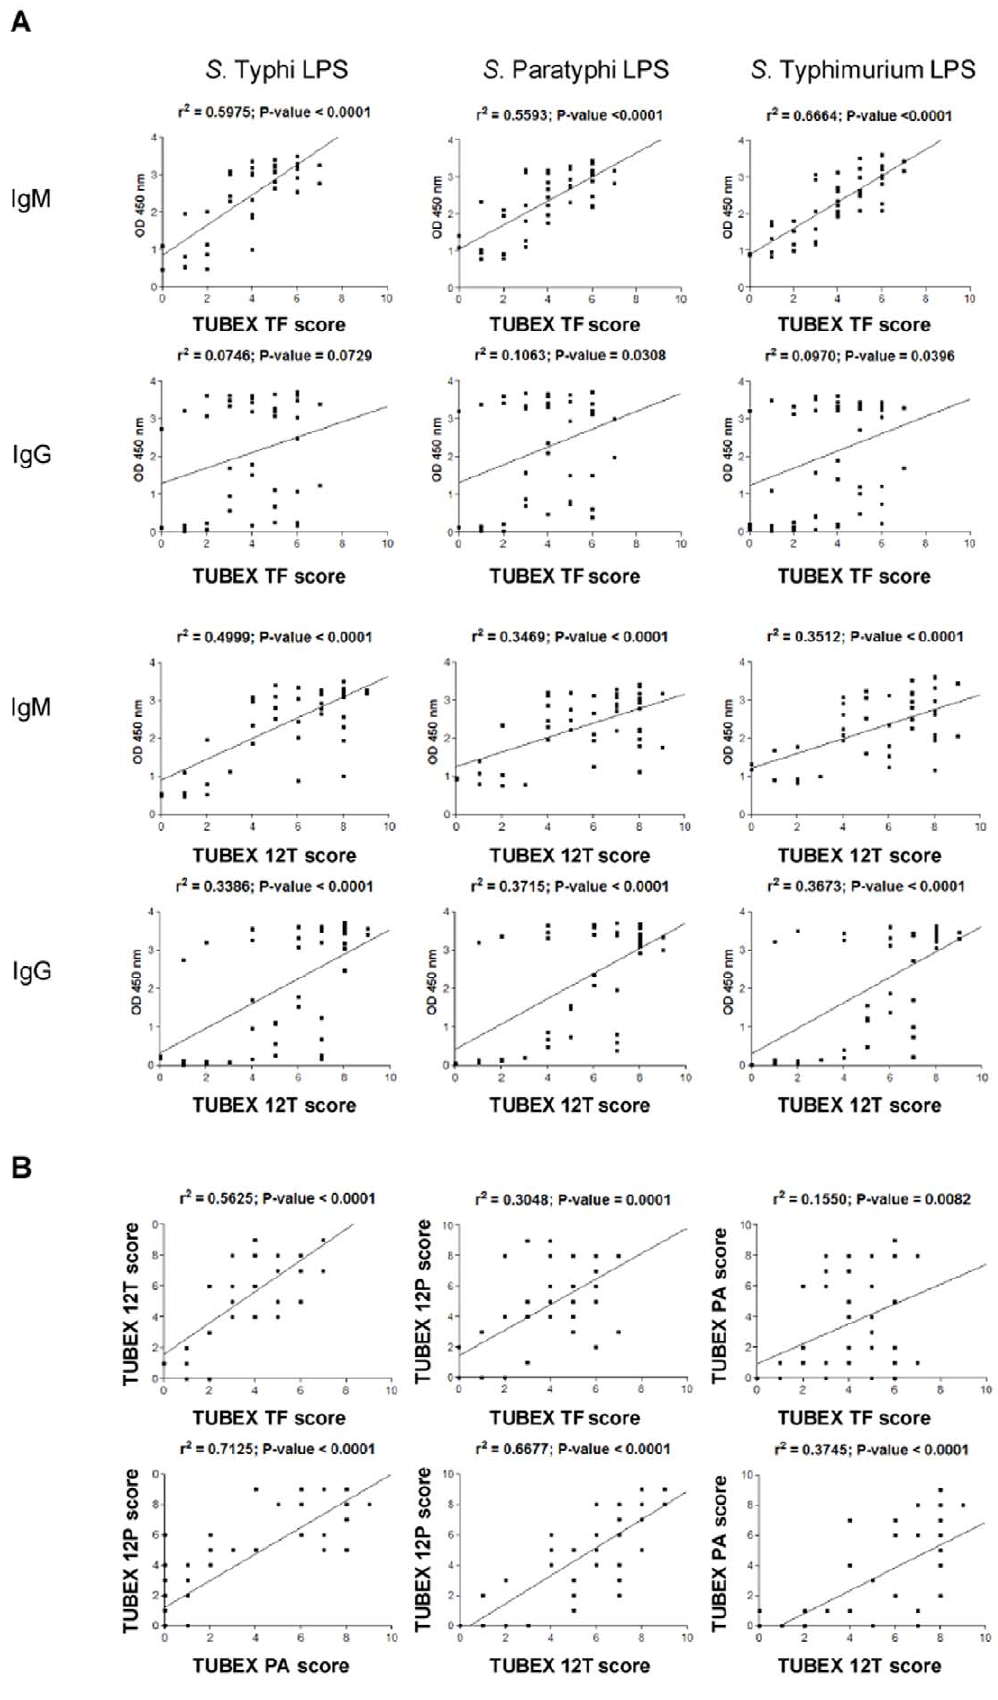
Figure 6. Regression analysis of various ELISA and TUBEX results obtained from typhoid patients. (Based on Table S1.) doi:10.1371/journal.pone.0024743.g006 PLoS ONE |